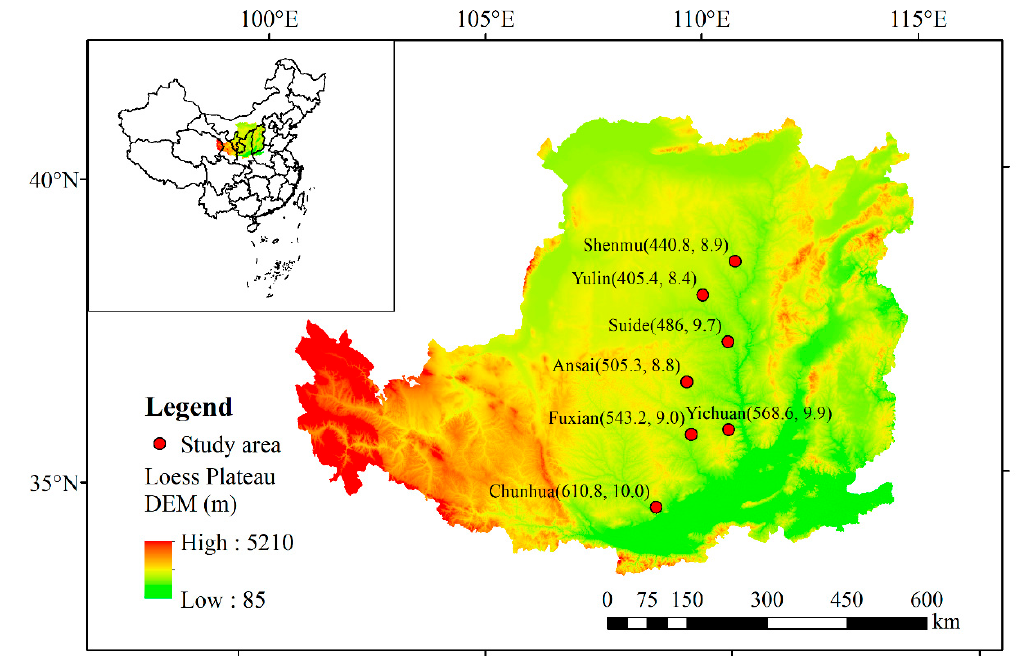
Figure 1. Location of the Loess Plateau in China and the study areas. Mean annual precipitation (mm) and mean annual temperature (°C) are marked beside the study areas.